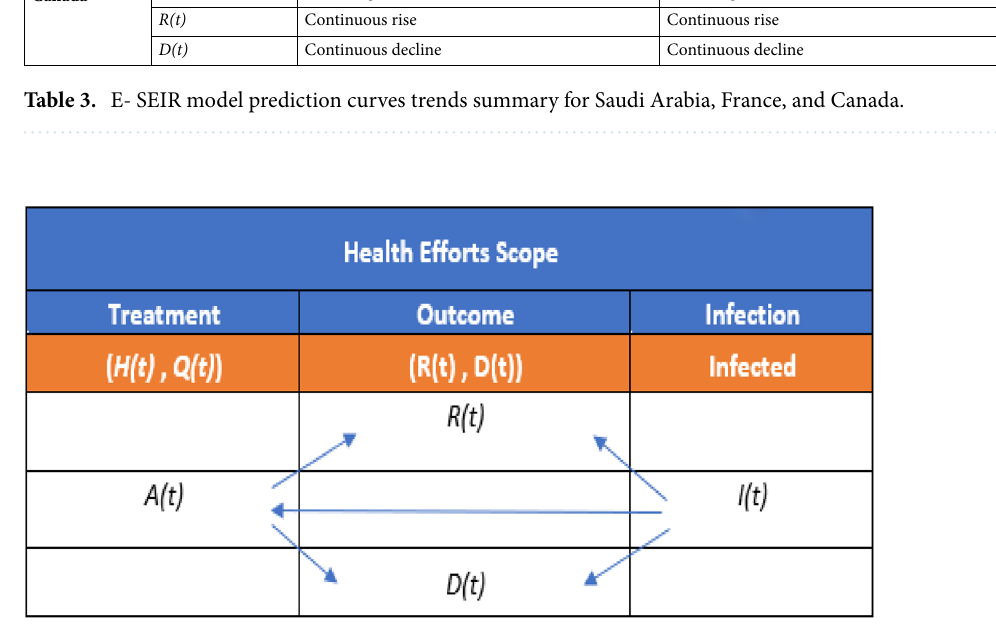
Table 4. Stage transition links from a health effort perspective.